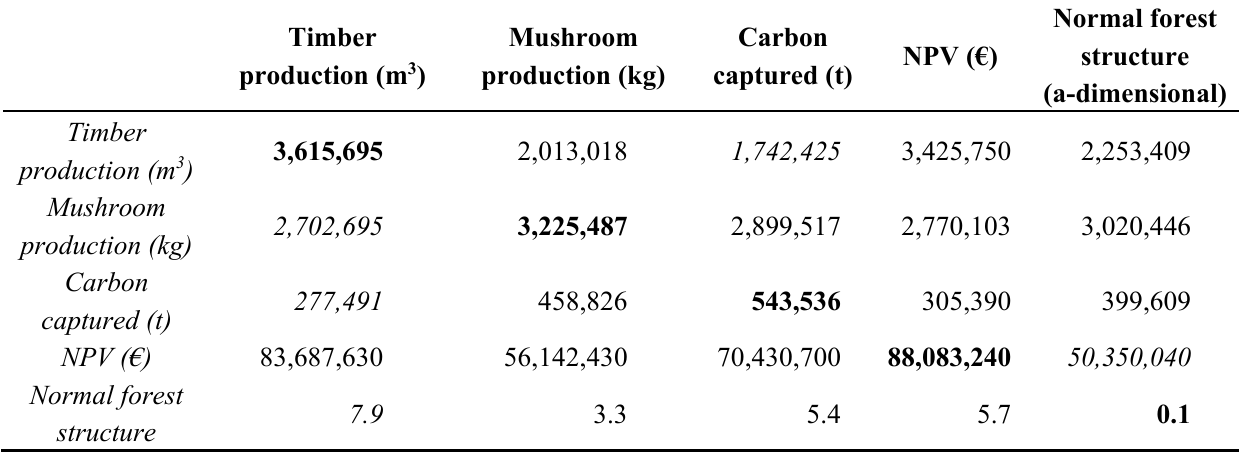
Table 2. Pay-off matrix under Scenario 2 (ideal values in bold; anti-ideal values in